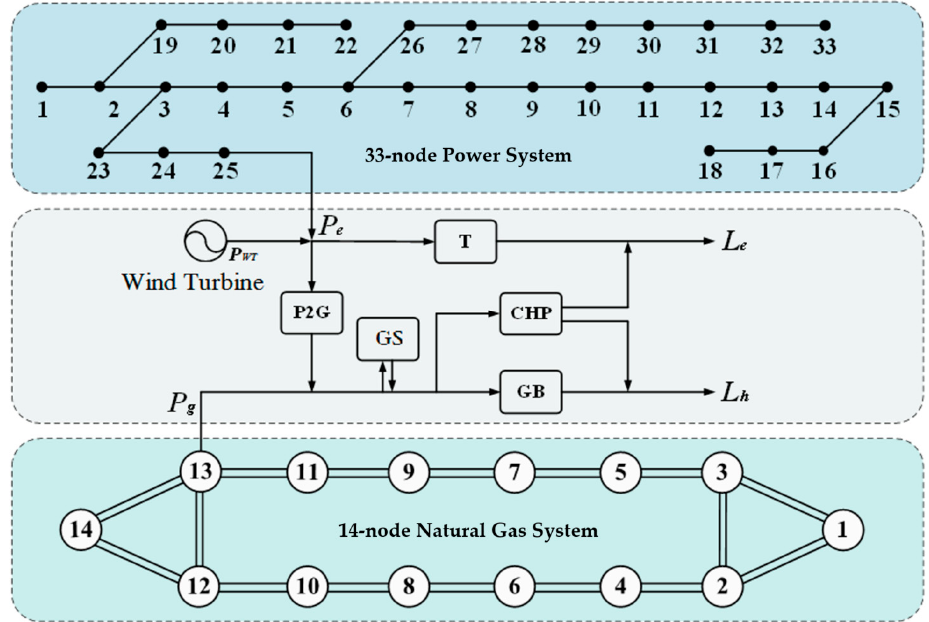
Figure 3. Structure block diagram of electric power–natural gas coupling system. The actual electricity, daily thermal load, wind power output and peak-valley time- sharing electricity price curve of the IES are shown in Figure 4. Natural gas price c g = 0.045 $/kWh, P2G operation cost coefficient c P 2 G = 0.009 $/kWh, abandoned wind penalty cost coefficient c w = 0.065 $/kWh.